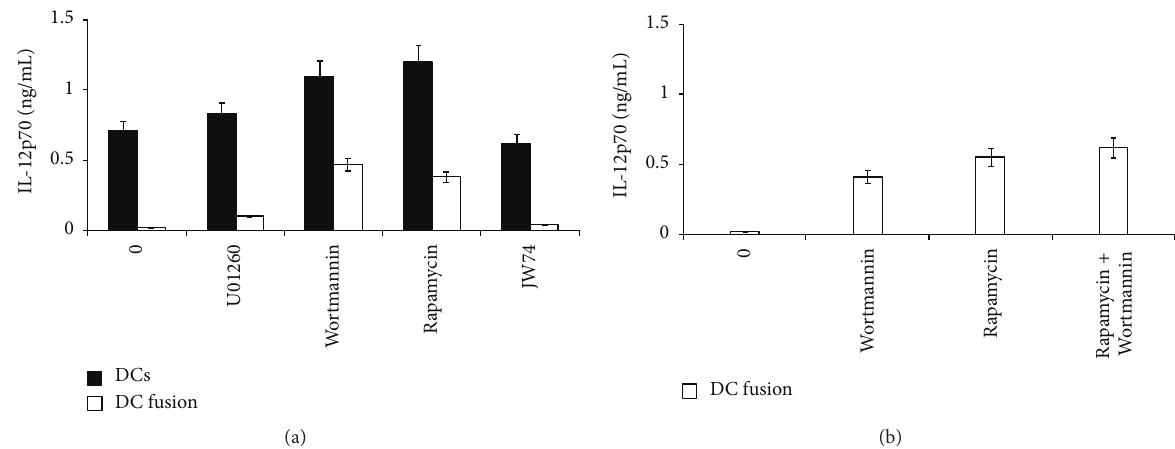
Figure 5: (a) Secretion of IL-12p70 by DCs and DC-tumor cell hybrids in the presence of signal transduction inhibitors. DCs (black bars) or DC-tumorcellhybrids(whitebars)werestimulatedwithLPSandsupernatantswereanalyzedbyELISAasdescribedinSection 2.Stimulations were performed in the absence of inhibitor (0), or in the presence of MEK inhibitor (U0126), PI3K inhibitor Wortmannin, mTOR inhibitor rapamycin, or JW74, an inhibitor of the canonical Wnt pathway. Experiments were performed in duplicate and the standard error of the mean is presented. (b) Secretion of IL-12p70 DC-tumor cell hybrids. DC-tumor cell hybrids were stimulated with LPS in the presence or absence of inhibitors as indicated. Experiments were performed in duplicate and the standard error of the mean is